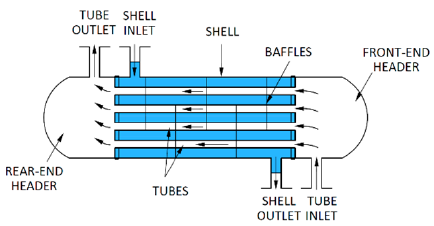
Figure 4. The schematic of shell-in-tube heat exchanger [27] .